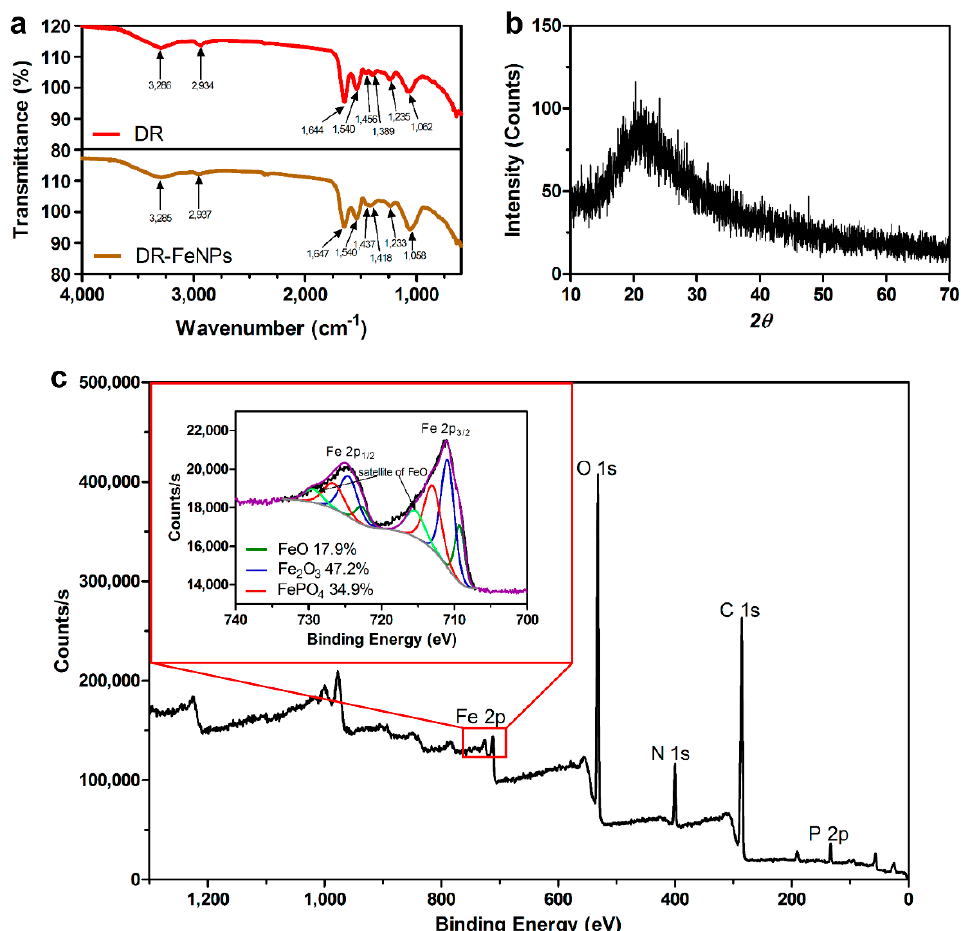
Figure 3. ( a ) FT-IR analysis of D. radiodurans R1 and iron nanoparticle immobilized D. radiodurans R1 (DR-FeNPs); ( b ) X-ray diffraction (XRD) pattern and ( c ) X-ray photoelectron spectroscopy (XPS) spectra of iron nanoparticle immobilized D. radiodurans R1 (DR-FeNPs). The red colored square indicated the magnified version of the Fe 2p signal.